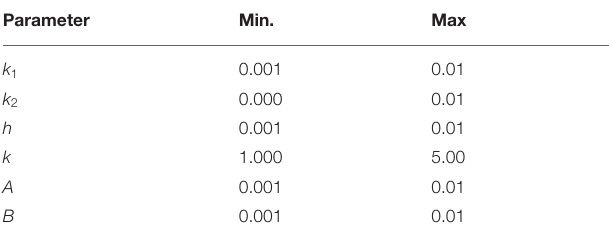
TABLE 3 | Parameters’ ranges used for the global sensitivity analysis of the model defined by Equations (15) and (16).